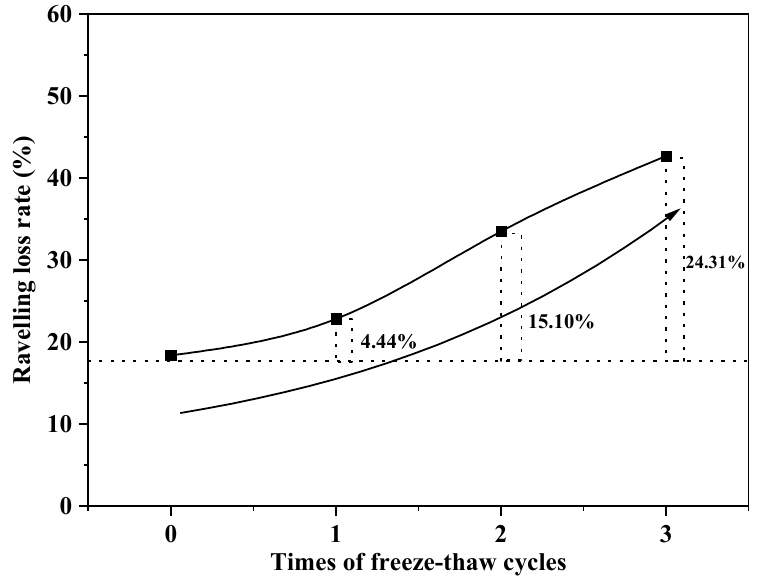
Figure 6. Effect of the freeze–thaw cycle test on the ravelling resistance performance of asphalt mixture.